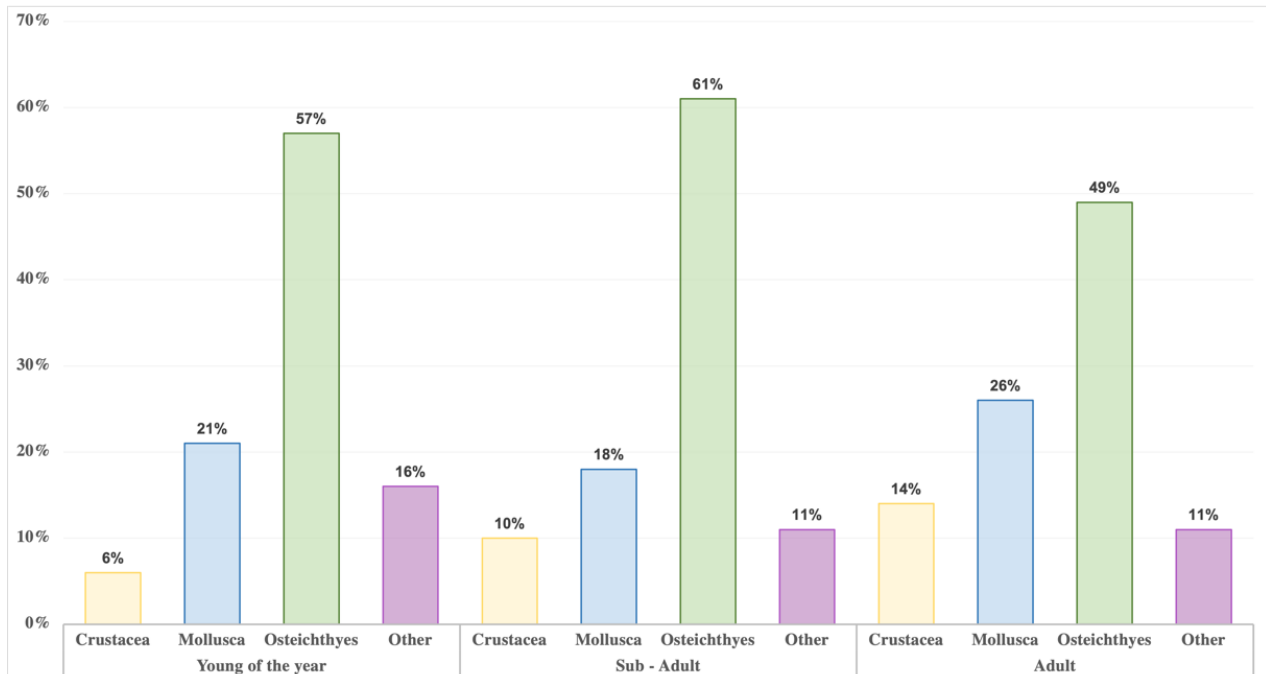
Figure 2. Percentage of items (N%) found in the stomach contents per age classes in the Latium population.